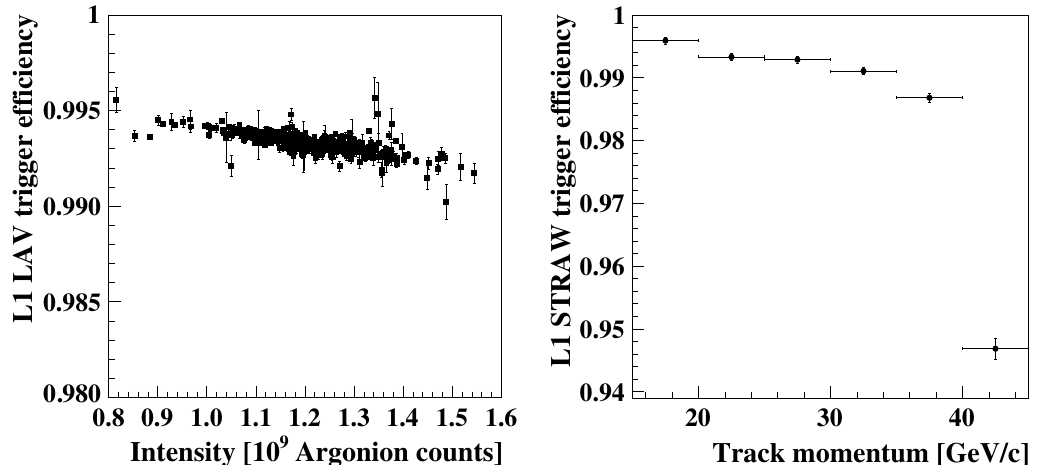
Figure 6. Efficiency of the L1 LAV trigger evaluated using K + → µ + ν events as a function of the average beam intensity (left), and efficiency of the L1 STRAW trigger condition evaluated using K + → µ + ν events as a function of the track momentum